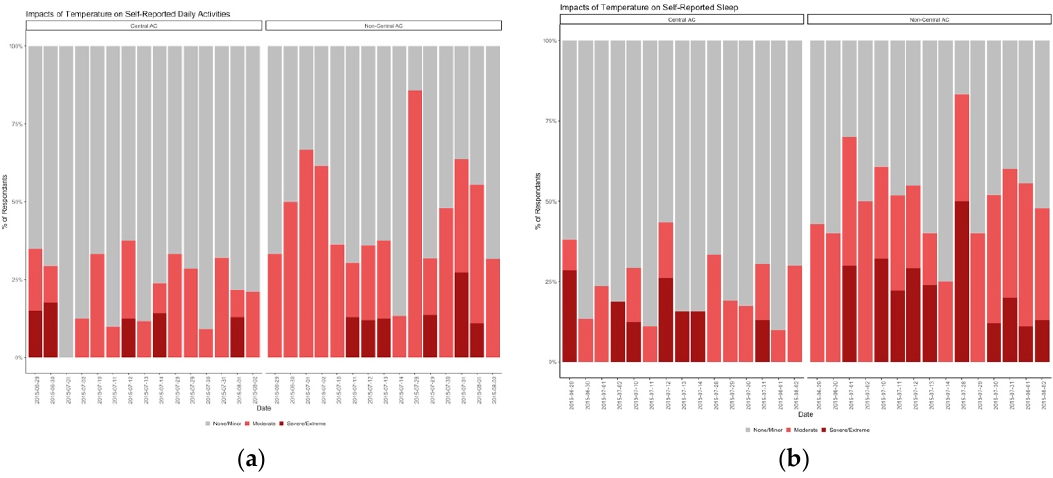
Figure 5. ( a ) Percent of respondents indicating the impact the thermal conditions of their apartment have on their self-reported daily activities. ( b ) Percent of respondents indicating the impact the thermal conditions of their apartment have on their self-reported sleep.